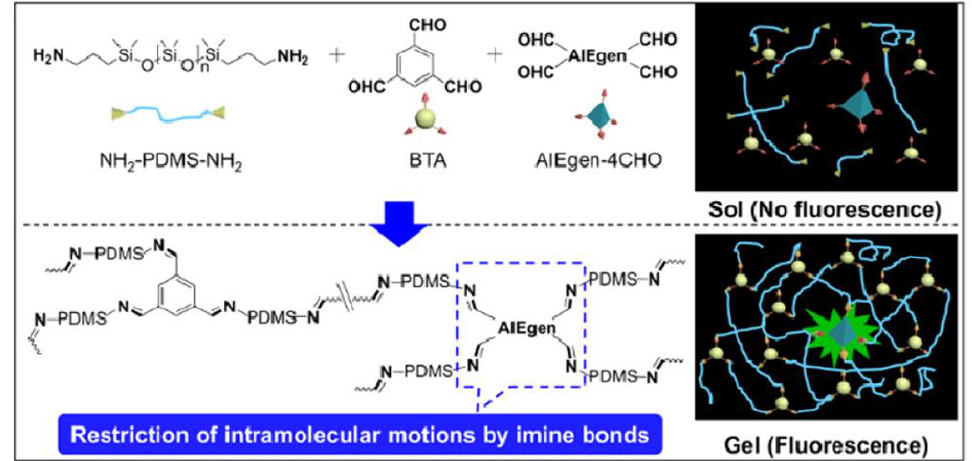
Figure 1. The formation of the emissive self-healing gel based on dynamic imine bonds and the luminescence mechanism in Ref. [29]. Reproduced with permission from Ref. [29]. Copyright 2019, American Chemical Society.